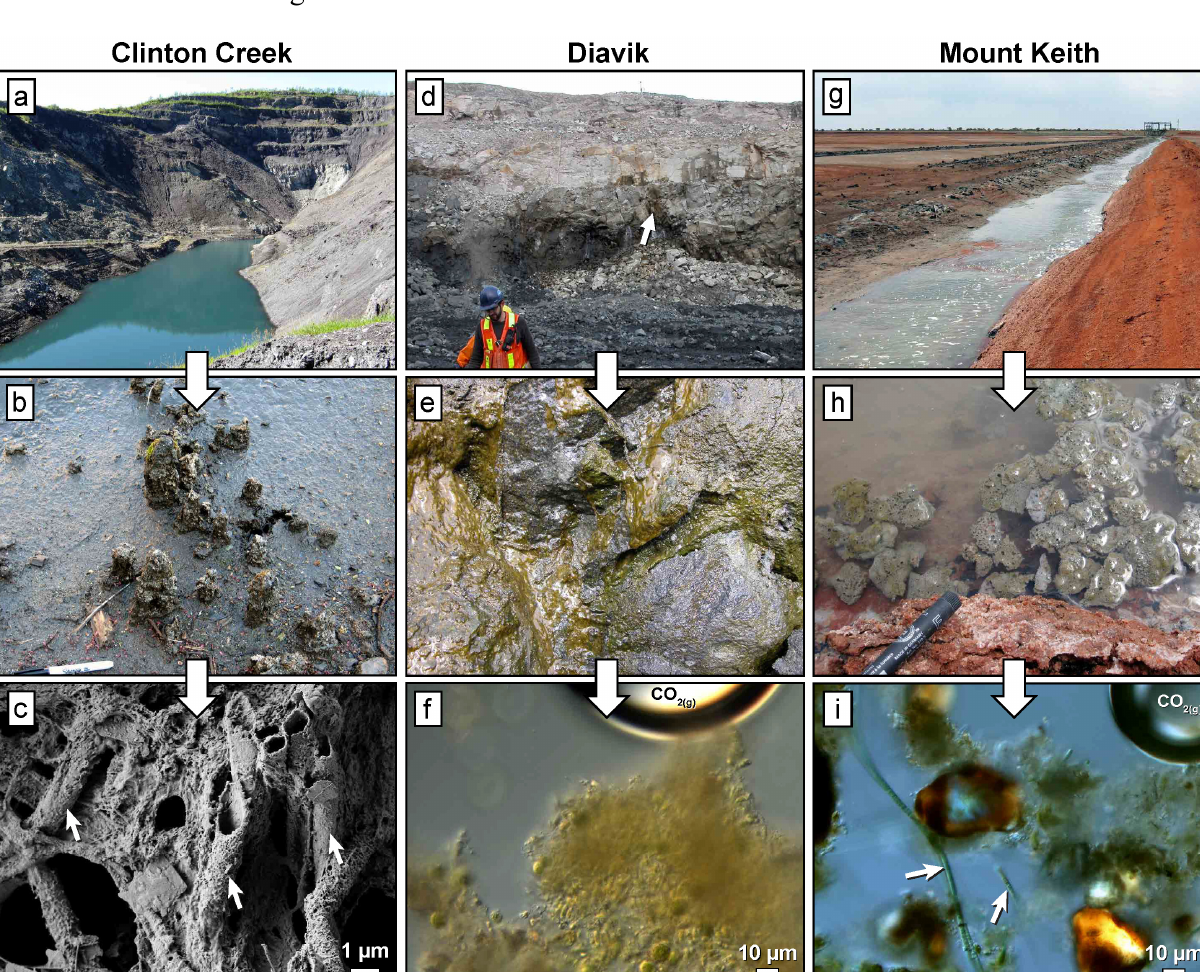
Figure 2. Evidence of microbe-carbonate interactions at Clinton Creek ( a – c ), Diavik ( d – f ) and Mount Keith ( g – i ). ( a ) Open pit pond at the Clinton Creek asbestos mine with ( b ) carbonate microbialites along the pond periphery (marker for scale) (after [37]). ( c ) scanning electron microscopy (SEM) micrograph of acid-etched thin section revealing filamentous cyanobacteria previously entombed in aragonite. ( d ) Open pit wall at Diavik showing water drainage (arrow) and biofilms ( e ) on rock surfaces (width of photograph is ~30 cm). ( f ) Biofilm is dominated by cyanobacteria and upon reaction with dilute acid, become visible under light microscopy. ( g ) Drainage channel for the TSF bubbles of CO 2 at Mount Keith with ( h ) floating microbial mats (marker for scale). ( i ) Light micrograph of microbial mat with tailings grains and small bubbles of CO produced from reaction with 2 dilute acid indicating an association with carbonate